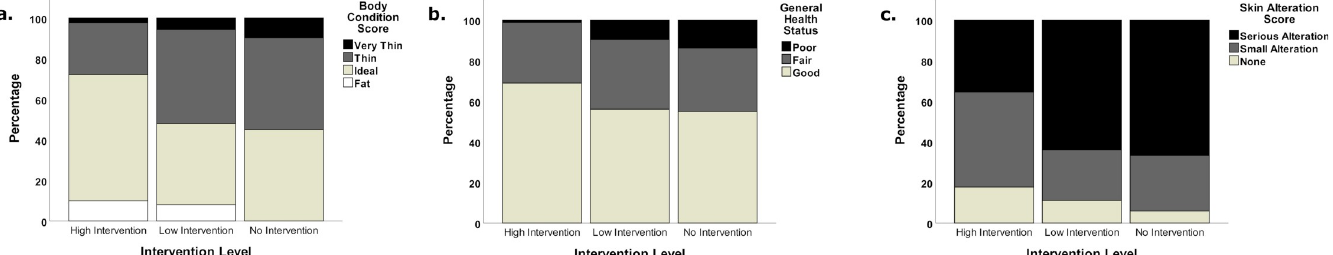
Fig 2. Stacked bar charts showing the percentage distribution of body condition scores, general health status scores and skin alteration scores across intervention levels.